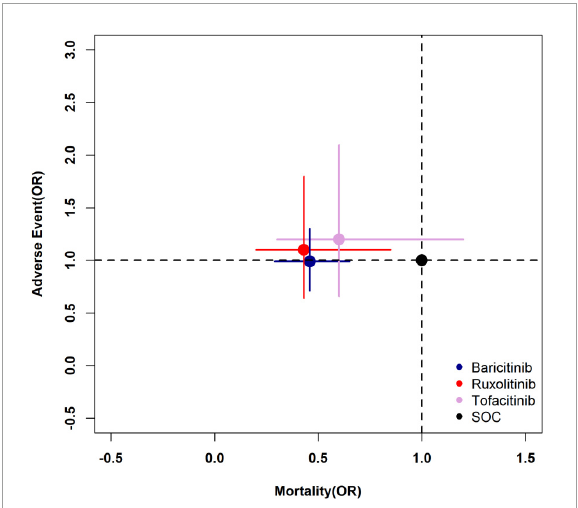
FIGURE7 Two-dimensional plot of primary outcomes. The longitudinal coordinate and horizontal ordinate are the odds ratio of mortality and adverse events of each drug to SOC (1.0, 1.0). SOC, standard of